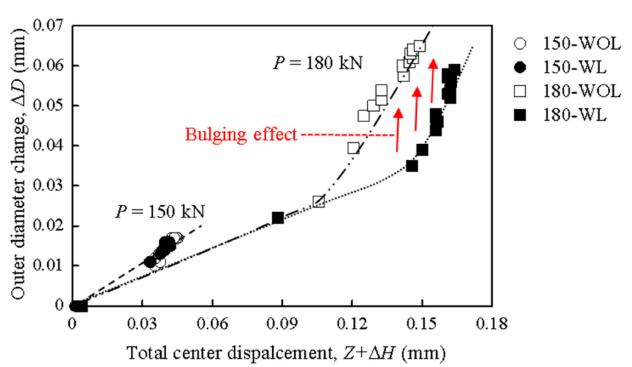
Figure 15. Relationship between the outer diameter change (near the working surface) and total center displacement. (150 / 180—Forging load (kN), WL—With Lubrication, WOL—Without Lubrication).